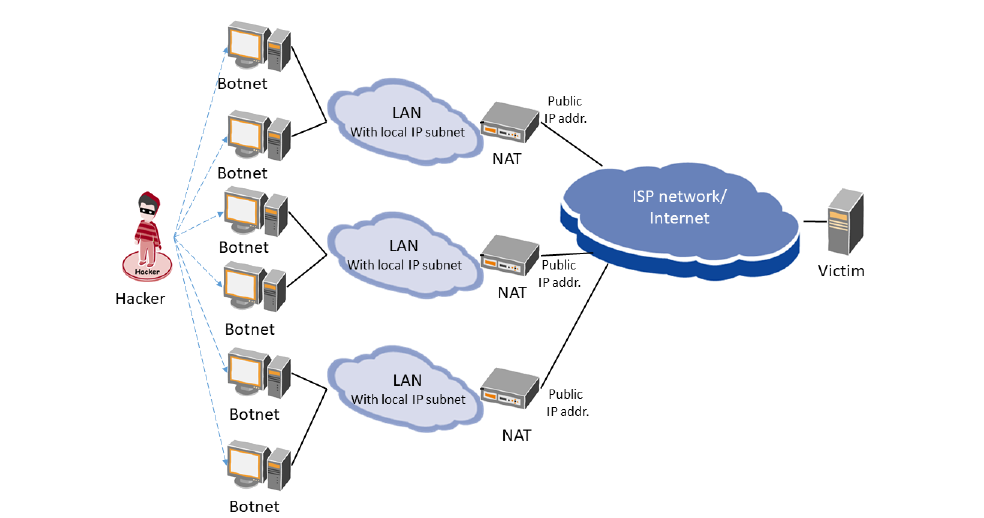
Figure 2. DDoS attack in an Internet Service Provider (ISP)